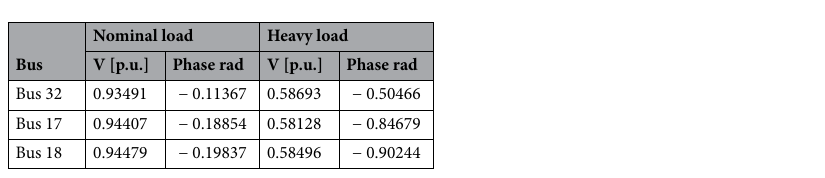
Table 1. Power flow